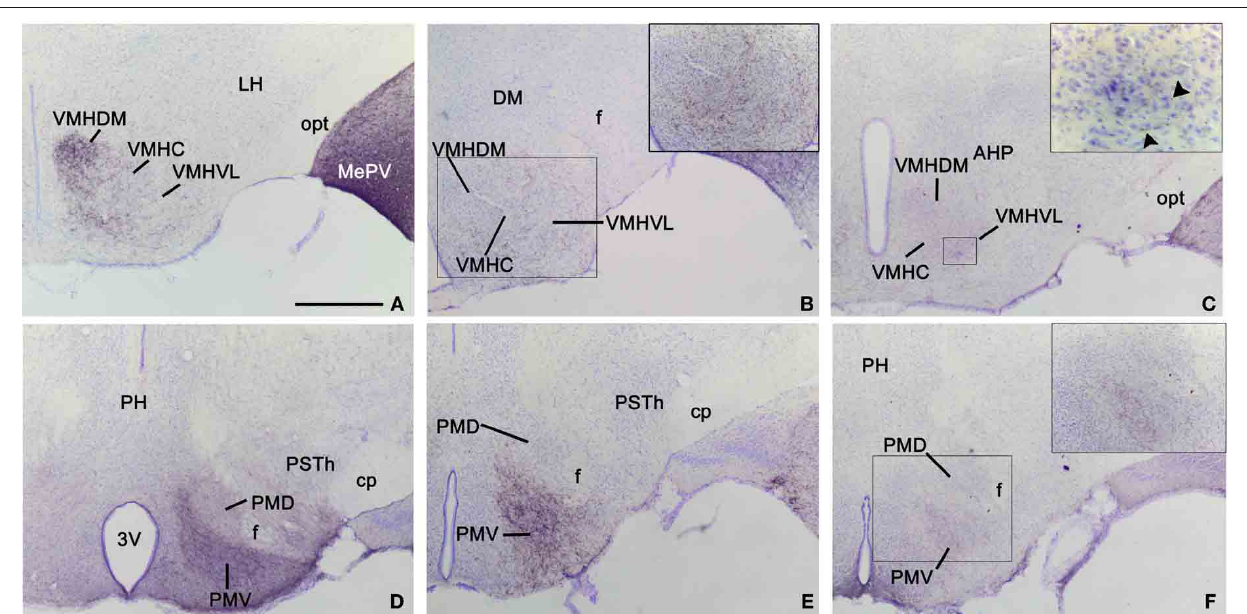
innervate preferentially the dorsomedial or ventrolateral subdivision. (D–F) Pattern of anterograde labeling in the premammillary hypothalamus. All three subdivisions of the medial amygdaloid nucleus mainly project to the ventral premammillary nucleus, with the densest projections originated by the MeA (D) and the MePD (E) . Premammillary hypothalamus photomicrographs correspond to a C57BL/J6 mouse injection (D) and CD1 mice injections (E,F) . For abbreviations, see list. Scale bar in A (valid for B–F ): 500 µ m.